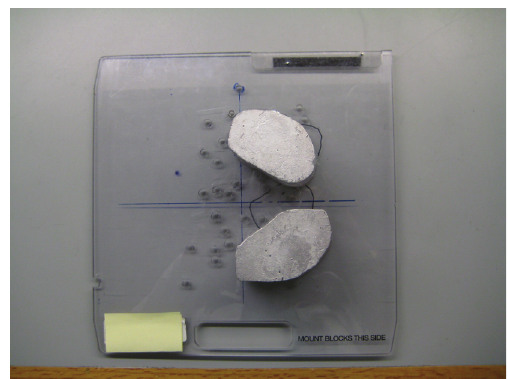
Figure 5: Blocks used to shield radiosensitive